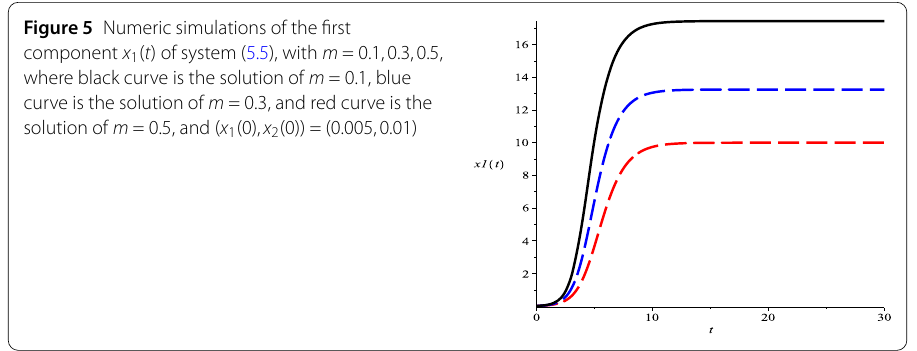
Figure 6 Numeric simulations of the second component x 2 ( t ) of system (5.5), with m = 0.1,0.3,0.5, where black curve is the solution of m = 0.1, blue curve is the solution of m = 0.3, and red curve is the solution of m = 0.5, and ( x 1 (0), x 2 (0)) = (0.005,0.01)